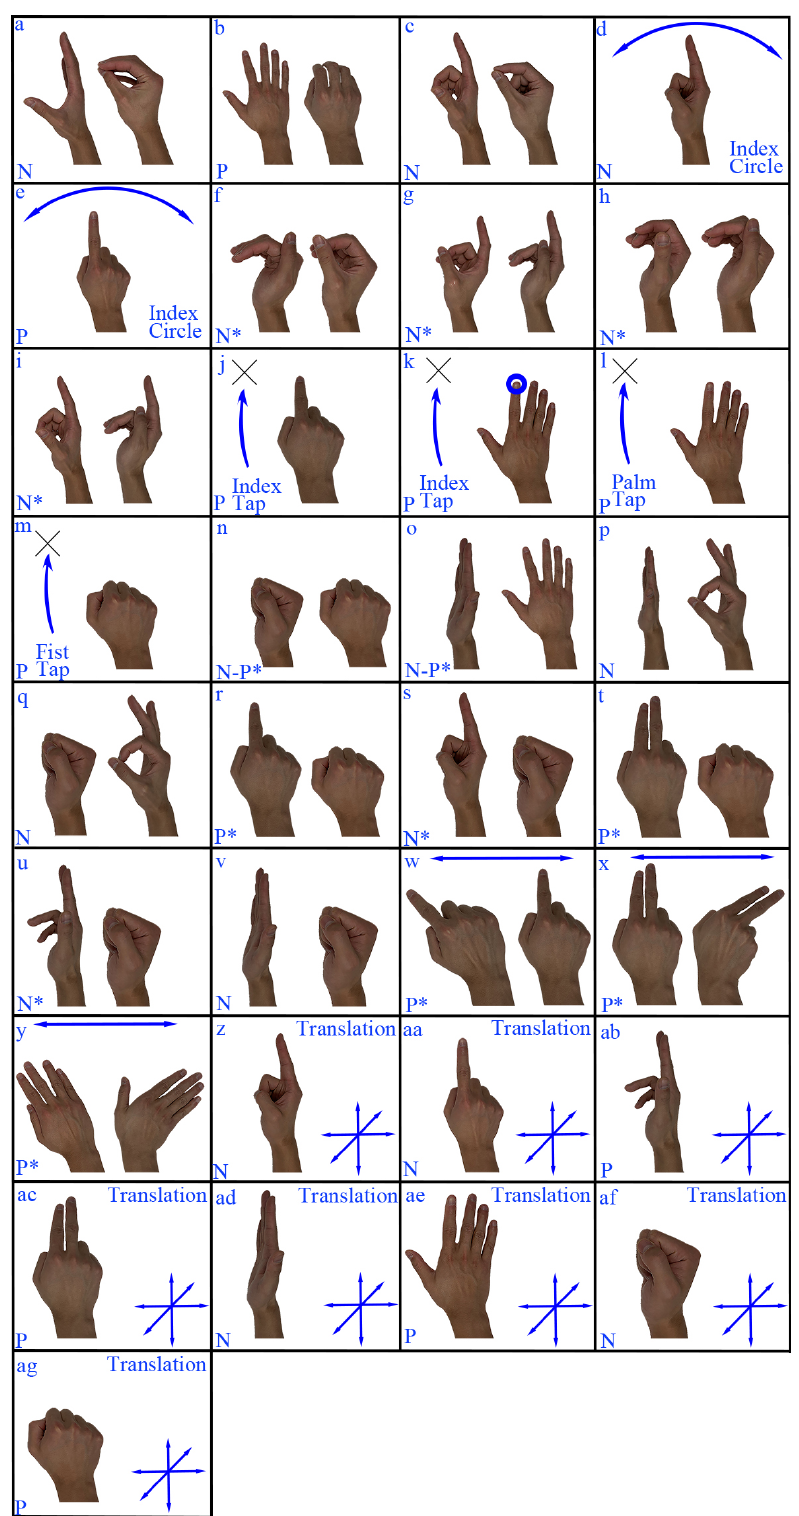
Figure 1. The graphical description of 33 designed microgestures. Microgestures with N, P, or N–P indicated that the forearm in the neutral, pronated position, or rotating from neutral to pronated position while microgestures with * were identified as unfamiliar gestures. The instruction on how to perform each microgesture could be checked in Table 2, for example, microgesture a was performed from extended fingers to close fingertips or the reversed